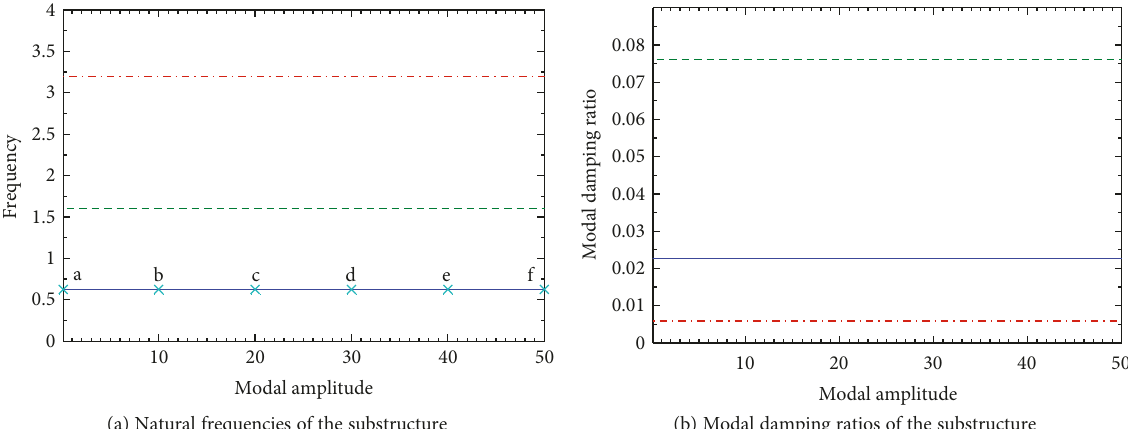
Figure 6: Modal information of the nonlinear substructure.